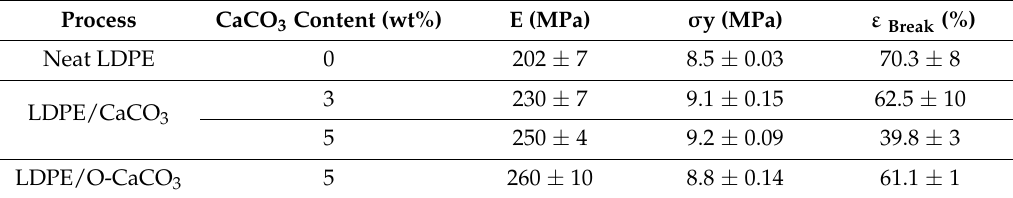
Table 2. Mechanical properties of LDPE and LDPE/CaCO 3